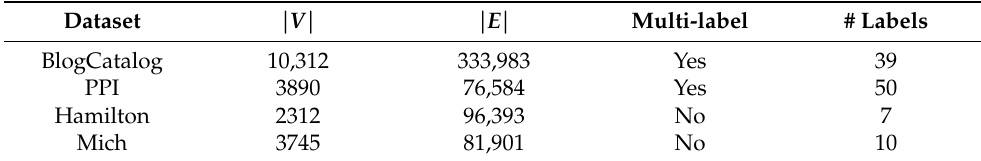
Table 1. Statistics of